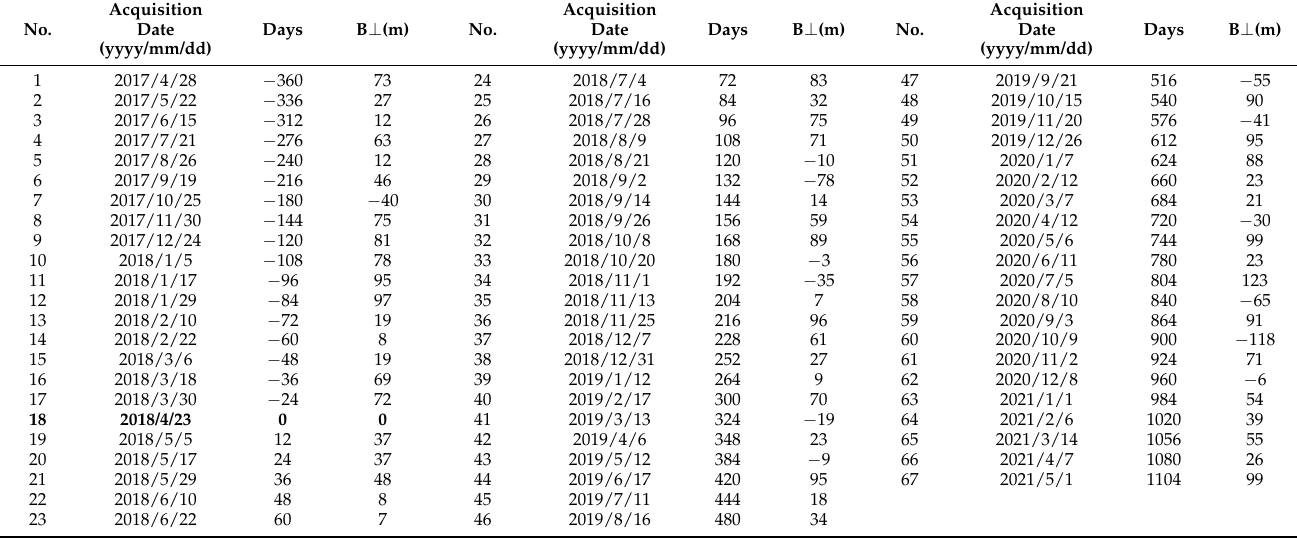
Table 1. The reference date shown in bold text shows the acquisition dates of data from the Sentinel-1 satellite in descending tracks. Delta days = number of days between each acquisition date. B ⊥ = perpendicular baseline.